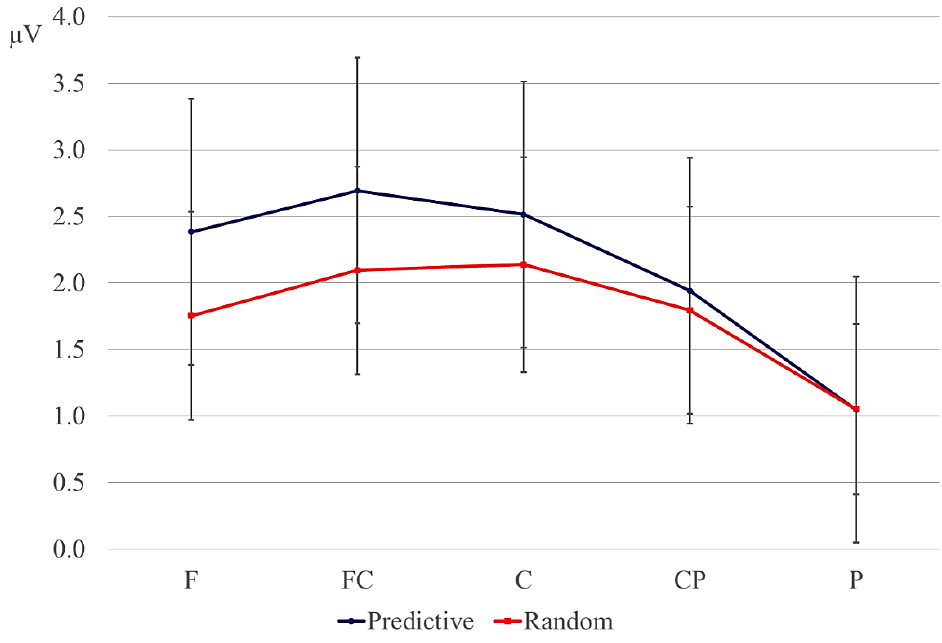
Figure 6. Mean amplitude (µV) between 180 and 280 ms from the onset of the second letter in the trial, for the lateral positions, collapsed over hemisphere and delay (error bars are standard errors). Blue lines: predictive sequences; red lines: random sequences. F: frontal;